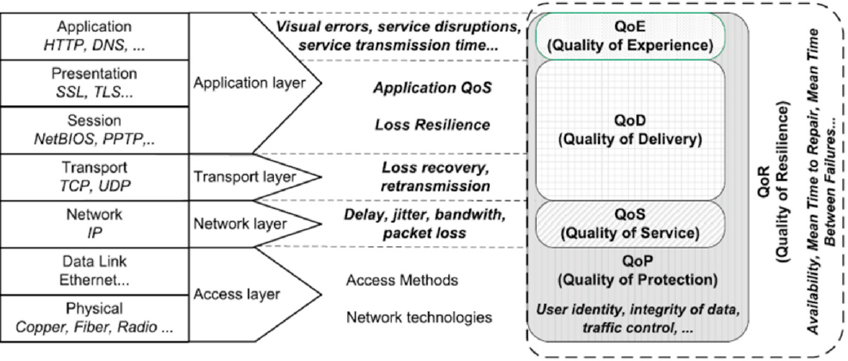
Figure 1. OSI-based classification of quality in relation with resilience [78].